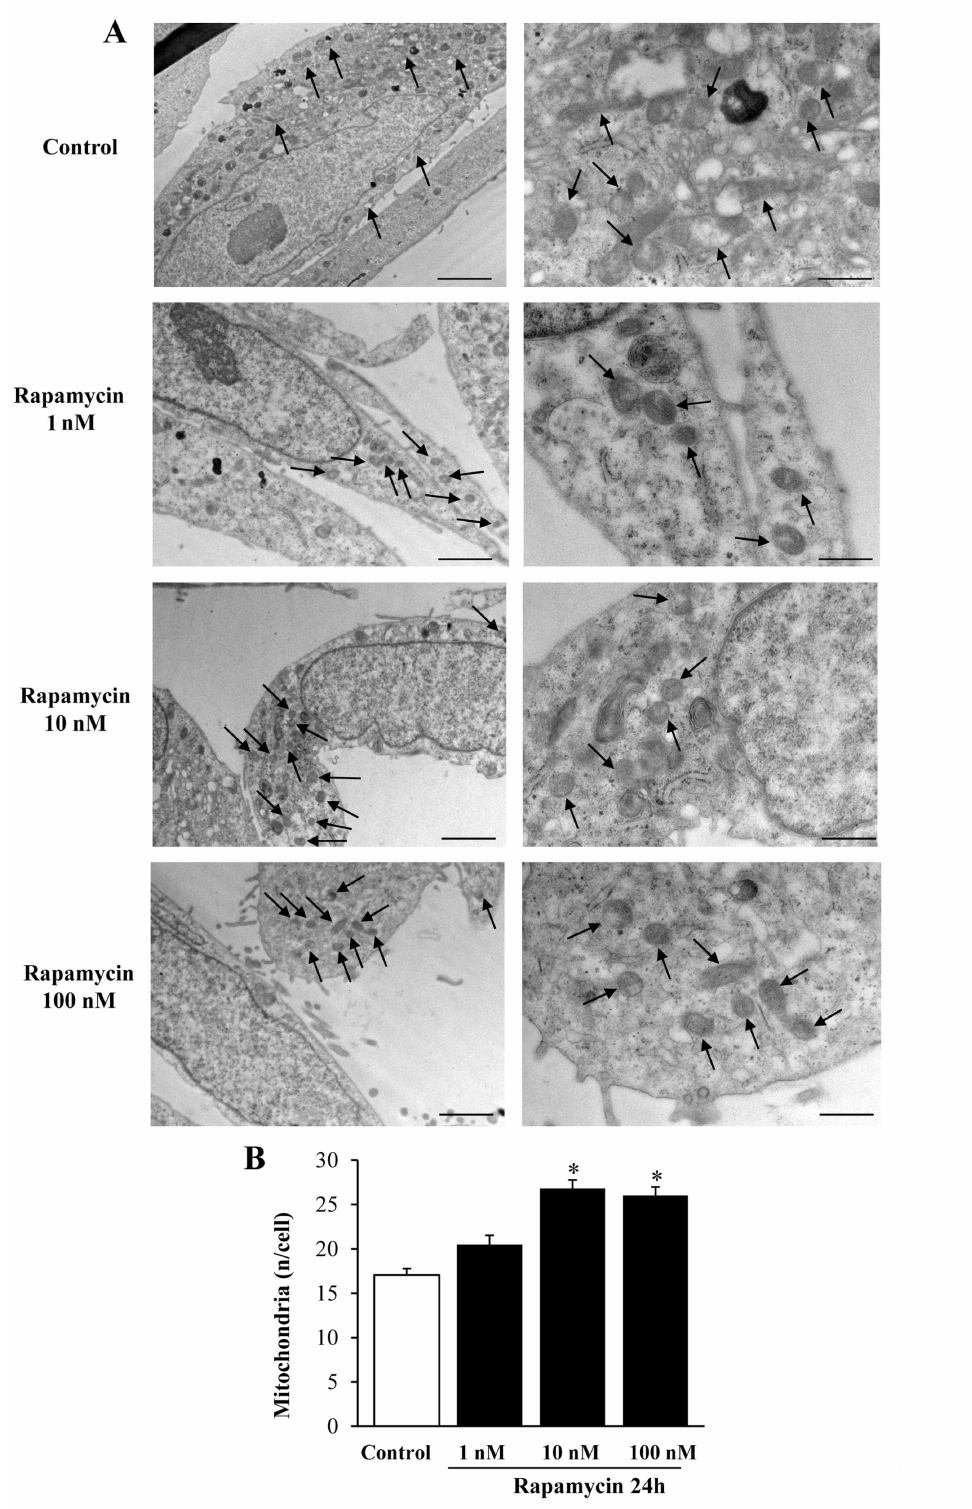
Figure 2. Rapamycin dose-dependently increases mitochondrial number in A172 cell line. ( A ) Representative TEM micrographs showing mitochondria (indicated by black arrows) from Control and from di ff erent doses of rapamycin. A more di ff erentiated cell phenotype is evident in Control cells when compared to U87MG cells shown in Figure 1. ( B ) Graph reports the number of mitochondria per cell. Values are the mean ± S.E.M. from 30 cells per group. ∗ p ≤ 0.05 vs. Control and 1 nM rapamycin. Scale bars = 1 µ m (low magnification) and 0.4 µ m (high